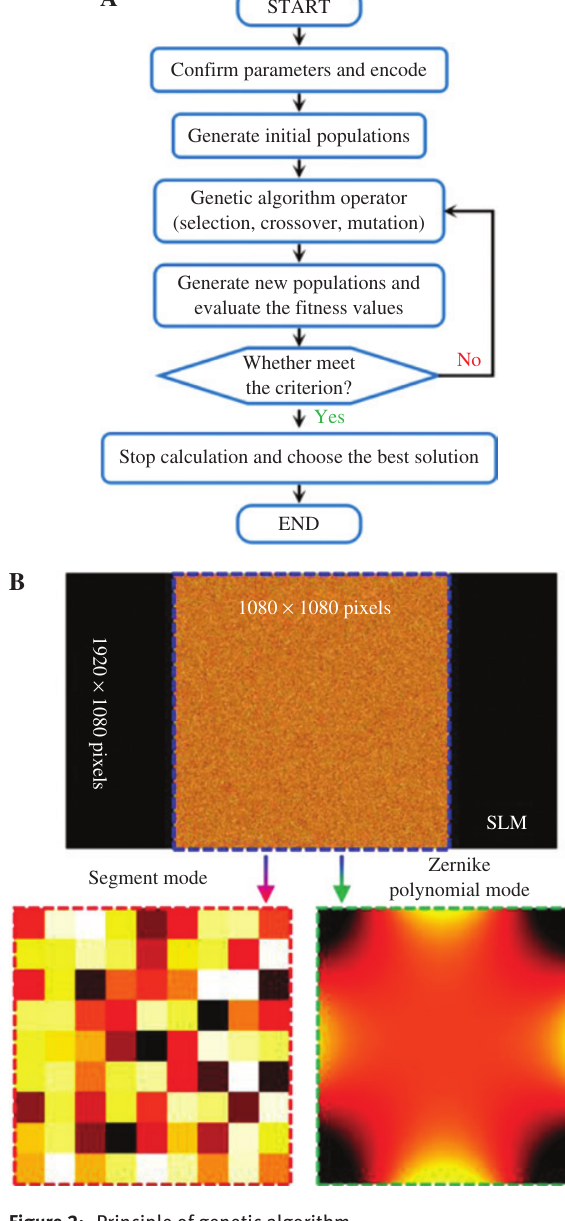
Figure 2: Principle of genetic algorithm. (A) The flowchart of genetic algorithm for finding the best solution. (B) Two encoded forms on SLM in GA